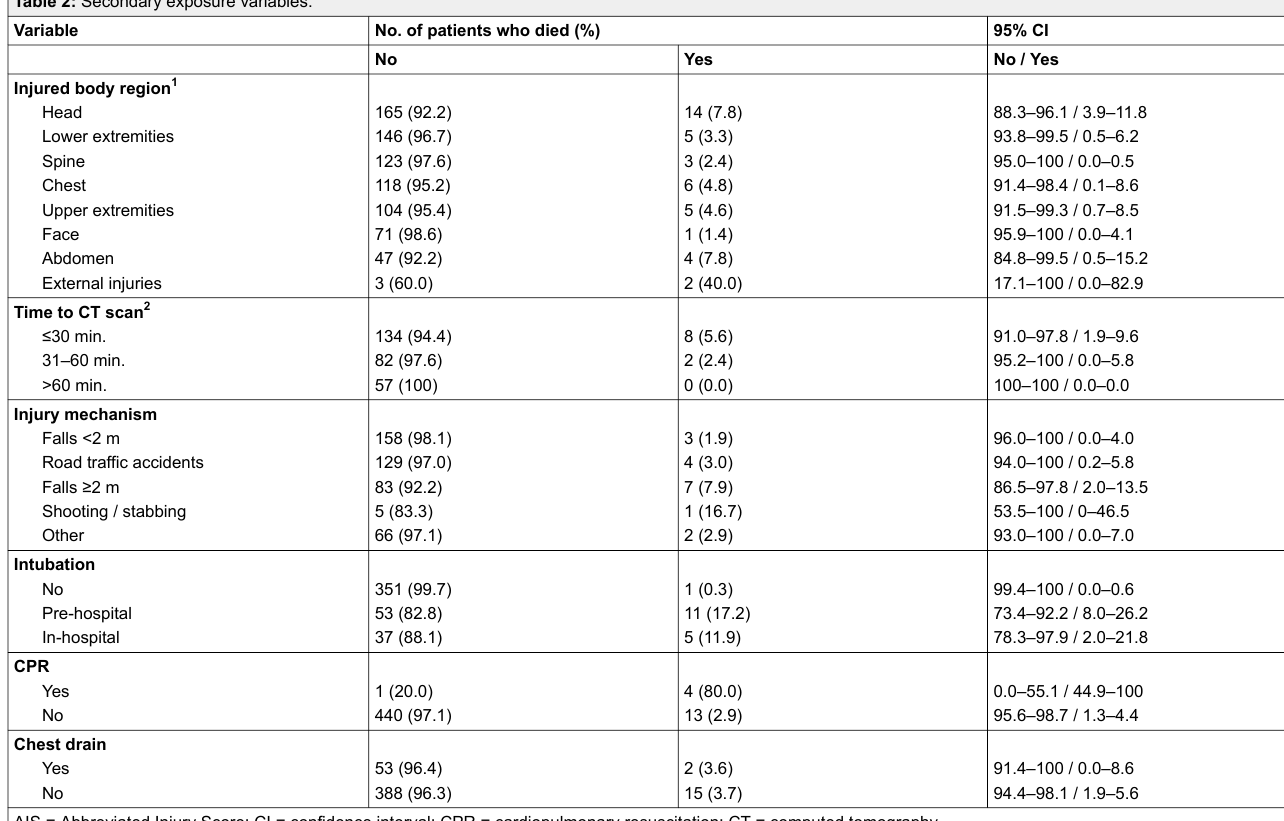
Table 2: Secondary exposure variables.